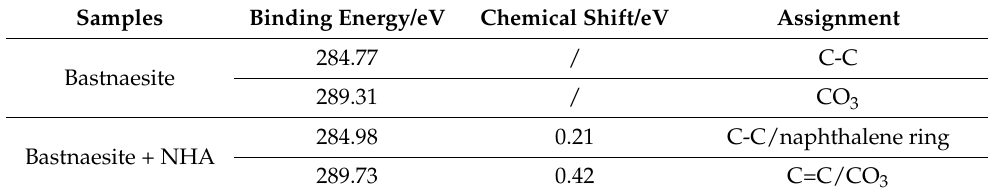
Table 9. Analysis results of C 1 s XPS spectra of bastnaesite samples untreated and treated with NHA. Samples